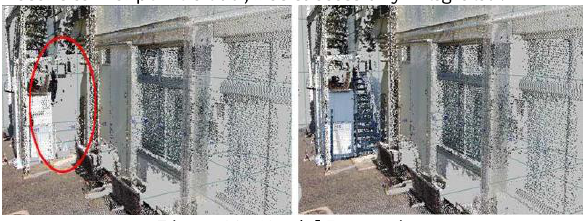
Figure 13. Model Integration. Left: Before Integration. Right: After Integration